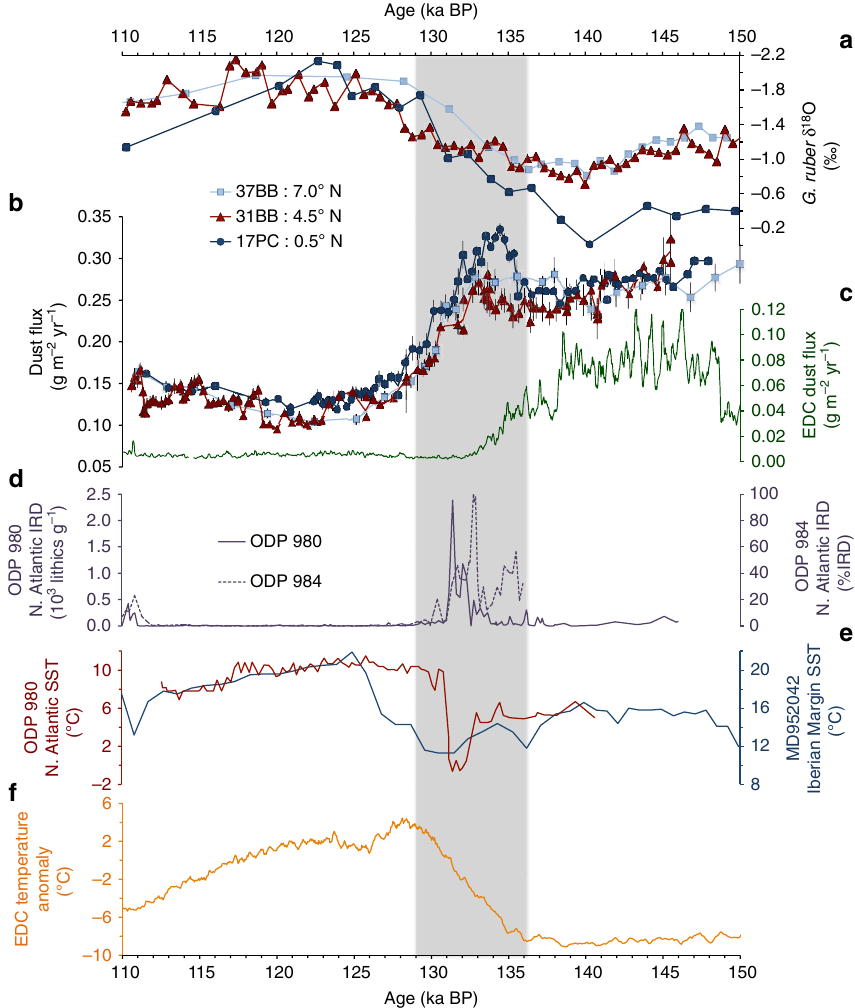
Figure 2 | Climate of the penultimate deglaciation. Planktonic foraminifera d 18 O stratigraphy for cores 37BB (light blue squares), 31BB (red triangles) and 17PC (navy circles) 19 ( a ). Dust flux records from 37BB, 31BB and 17PC. Symbols as in a , error bars are 2 s.d. Lines connect data points and the mean value of replicates ( b ). Dust flux from Antarctic ice core EDC 17 (75 (cid:2) 06’ S, 123 (cid:2) 21’ E) on AICC2012 chronology 41 (5pt smoothed) ( c ). North Atlantic (N. Atlantic) ice-rafted debris (IRD) abundance from sites ODP 980 (55 (cid:2) 29’ N, 14 (cid:2) 42’ W) and ODP 984 (61 (cid:2) 25’ N, 24 (cid:2) 4’ W) 42 ( d ). North Atlantic sea surface temperature (SST) proxy records from ODP 980 (ref. 29) on the timescale of Mokeddem et al. 42 (red line), and MD952042 (ref. 43; navy blue line) ( e ). Antarctic EDC temperature anomaly record 44 on AICC2012 chronology 41 (5pt smoothed), where the anomaly is relative to the last 1,000 years ( f ). Grey shading represents Weak Monsoon Interval II (WMI-II) 27 correlated with HS11 in the North Atlantic. Principles underlying the interpretation of proxies in e and f are discussed in Supplementary Note